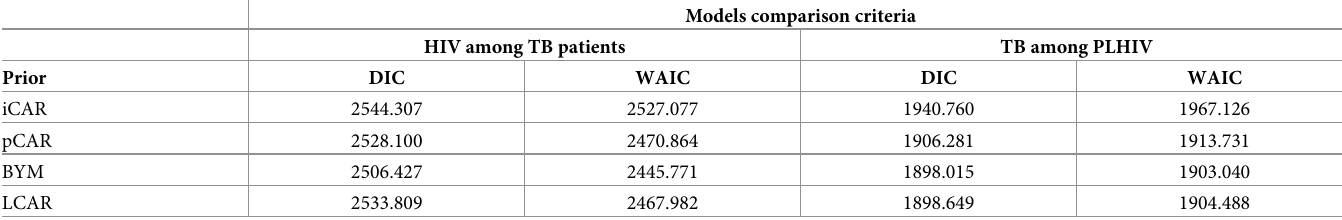
Table 3. Summary of DIC and WAIC values for different priors used to fit the Bayesian spatial models on prevalence of HIV among TB patients, and TB among PLHIV.